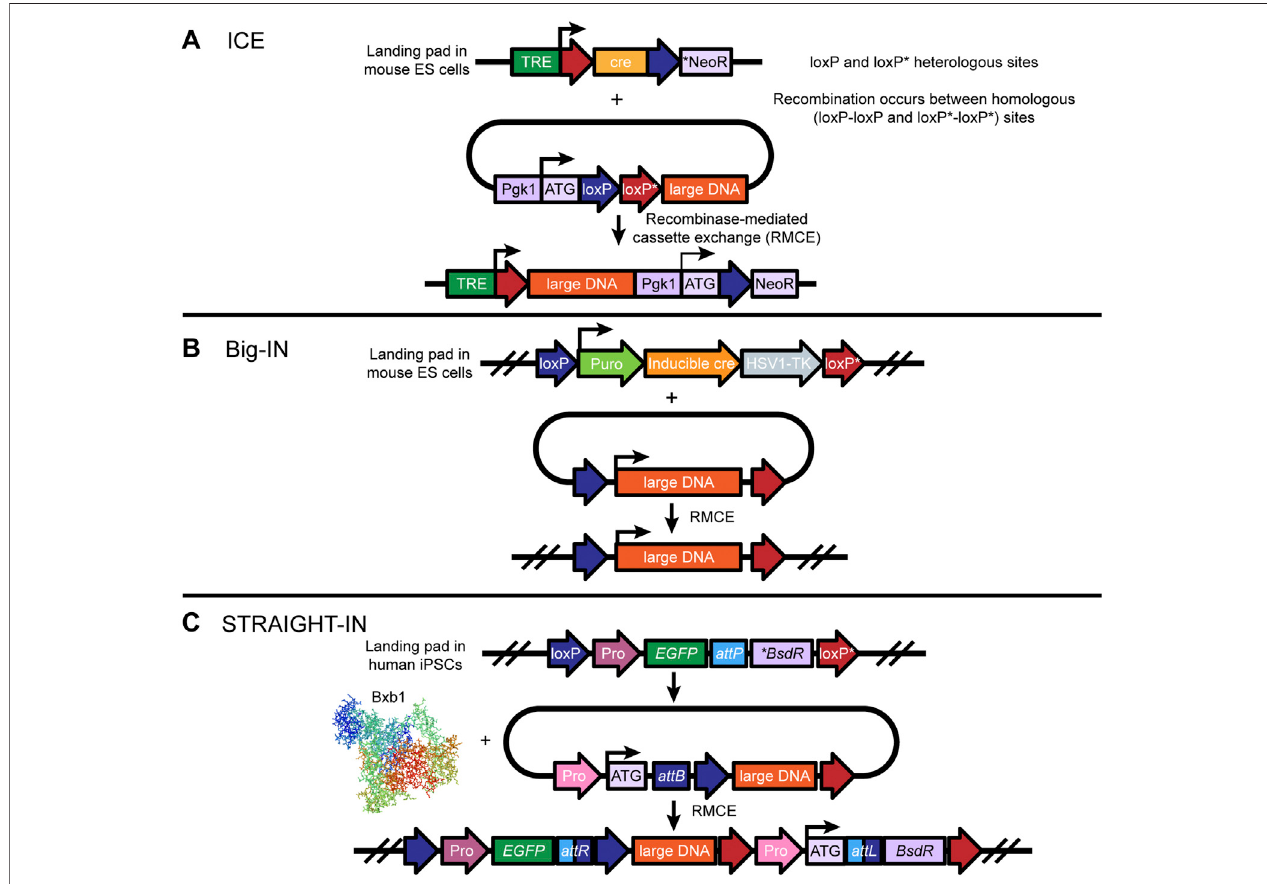
FIGURE5| Designand implementationoflarge DNAtransgenesisinmouse ESCsand humaniPSCs: (A) TheICE(adaptedfromIacovino,Bosnakovski,Fey etal.) (Iacovinoetal.,2011)toolusesalandingpadsiteinthesafeharborlocus,whichcontainsthecrerecombinasegenedrivenbythetetracycline-responsivepromoter(TRE) andaninactiveneomycinresistancegene(NeoR)lackingapromoter,aconsensusKozaksequence,andatranslationinitiationcodon(ATG).Notably,onlythecregeneis fl anked bytwoheterologous loxP/loxP* sites. Followinginsertionofthelanding pad,largedonorDNA fl anked bytwoheterologous loxP*/loxP sites, intheopposite orientation, is integrated into the landing pad via doxycycline/tetracycline-induced expression of cre-recombinase. Cre is then replaced by the large DNA, which allows the neomycin resistance gene to be turned on for positive selection of ES cells that have been correctly integrated. (B) Big-IN (adapted from Brosh et al.,2021) is also a cre-mediatedRMCE-basedtechniqueforreplacinglargesectionsofmammaliangenomes.UsingCRISPR/Cas9-mediatedHDR,alandingpadsiteisinsertedintoasafe harborlocusinmouseEScells(orhumancells)toef fi cientlyengineermouseandhumancells.InsertionoflargeDNAcontainingapromotertodrivepuromycin, inducible cre,and anHSV1-TK gene, fl ankedbyheterologous loxP and loxP mutant( loxP* )sites, enablescre-mediated recombination oftwopairsofheterologous loxP and loxP* sites, resulting in large DNA cassette exchange. While puromycin allows for selection and isolation of a landing pad containing ES cells, correctly integrated ES cell lines can be counter-selected by ganciclovir. Modi fi ed ES cells can be taken to germline transmission. (C) The Straight-IN (adapted from Grandela et al., 2021) tool uses a combination of Bxb1 (or phiC31)- and cre-mediated recombination to insert a safe harbor locus in human iPSCs for large DNA transgenesis. Similarly to the ICE approach, Straight-IN uses a heterologous loxP and loxP* site- fl oxed landing pad cassette containing an attP site, an inactive antibiotic resistance gene (*BsdR), and a fl uorescent reporter gene driven by a constitutive promoter such as pgk1. The donor vector consists of a cognate attB site, a constitutive promoter preceding a translation initiation codon (ATG), and the DNA payload fl oxed by heterologous loxP and loxP* sites. Successful Bxb1-mediated integration of large DNA results in the formationofattRandattLrecombinationsitesandactivationoftheantibioticgeneforpositiveselectionofclones.Finally,thedouble loxP and loxP* sitesmakeitpossible to remove the selection markers, which are the fl uorescent reporter and the antibiotic